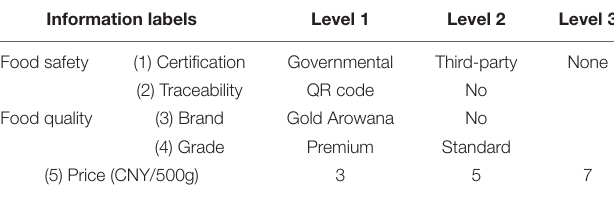
TABLE 1 | Information labels of rice products in choice